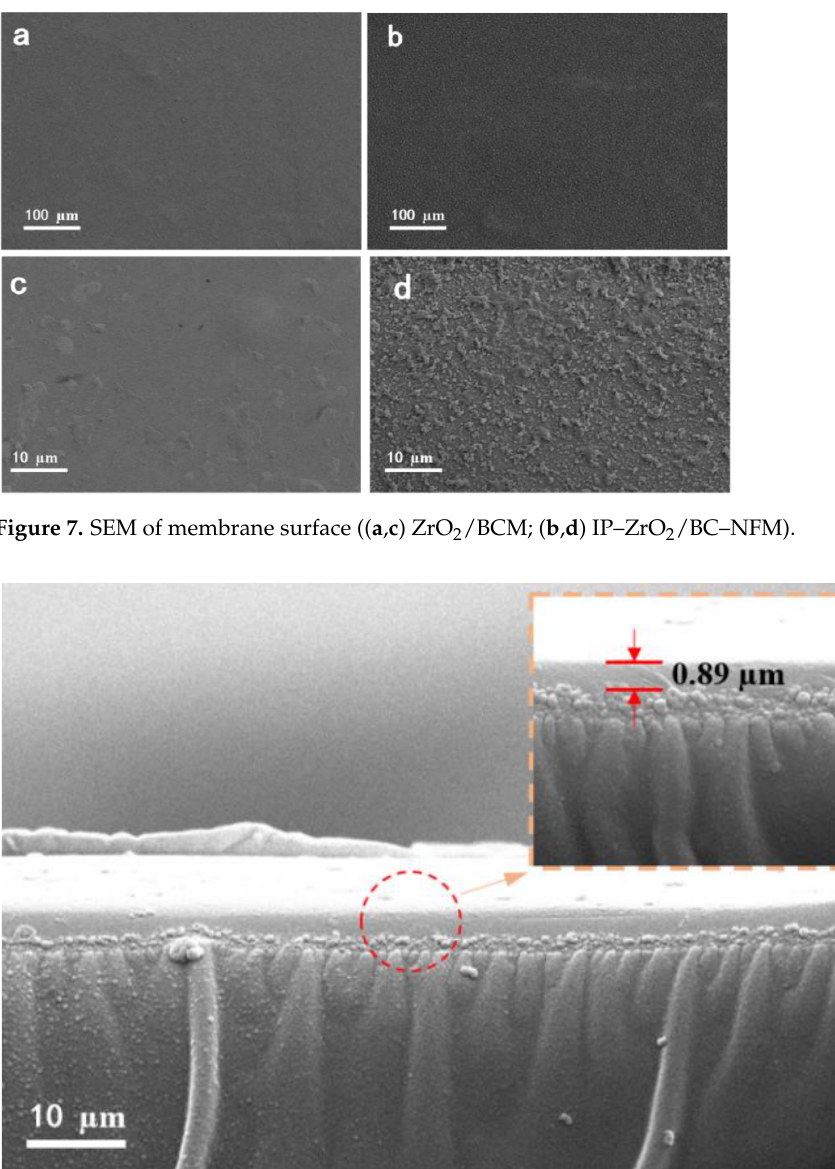
Figure 6. Effects of TMC and PIP concentration on water flux ( a ) and desalination effect ( c ); Effects of TMC concentration and polymerization reaction time on water flux ( b ) and desalination effect ( d ).